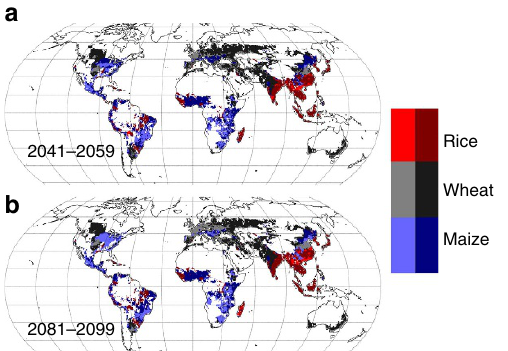
Figure 2 | Yield vulnerability of dominant crop. Maps show grid-cells where the dominant crop by area is projected to undergo reductions in attainable yield of at least 10% by 2041–2059 ( a ) and 2081–2099 ( b ) relative to the reference period. The dominant crop is indicated by colour, with darker shades indicating that the attainable yield is maintained or increased, and lighter shades indicating areas in which it undergoes a decrease 4 10%. Only grid-cells where the sum of cropped area of wheat, maize and rice exceed 1,000ha are shown 18 .